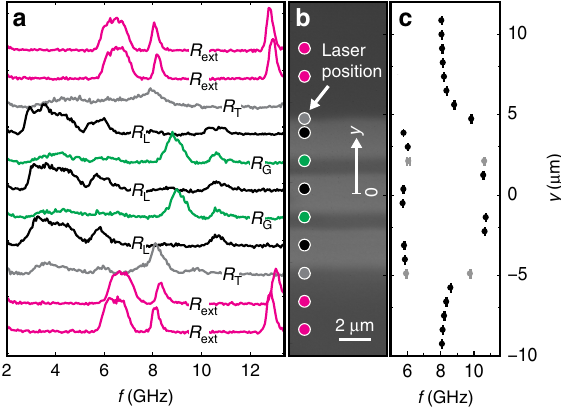
b Fig. 5 Group velocities of exchange magnons. a Emission of exchange magnons evidenced by BLS. Time-resolved magnon intensities measured at indicated positions Pos1 of mCPW1 and Pos2 of mCPW2 are depicted as blue and green line, respectively. The measurement was conducted at μ H = 0.087 T. A microwave pulse with 6.64 GHz was applied to mCPW1. 0 A rise in BLS intensity was fi rst observed at Pos1 and with a delay of Δ t = = 28 μ m. 43 ± 3 ns at Pos2, which was separated from Pos1 by Δ y tr b Average group velocities (open squares) extracted for sample 1 from VNA transmission signals using v g = Δ f × Δ y e-e . The solid curve represents calculated velocities v g assuming a backward volume spin-wave dispersion relation at 0.09 T (see “ Methods ” ). Inset: Δ f was extracted from oscillations in the imaginary (Im) part of the transmitted magnon spectra S 21 , when at least three periods of oscillations appeared. Error bars are the standard deviation of v g indicated by those three oscillations. Source data are provided as a Source Data fi parameter s eff estimated the length of YIG over which the pro- between mCPW1 and mCPW2. For the symbols shown in Fig. 5b, we assumed s eff = Δ y e-e = 25.9 μ m. The good agreement between extracted data (symbols) and the predicted group velo- cities indicates that the phase shift Δ φ along s cc is accumulated mainly across region R ext where we assume the propagating